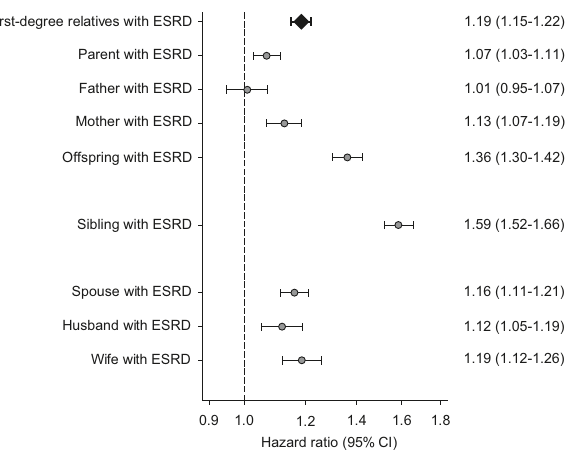
Figure 2. Risks of ESRD in patients with predialysis CKD having affected relatives with ESRD. All models were adjusted for age, sex, residential area, income level, and comorbidities such as hypertension, diabetes, ischemic heart disease, cerebrovascular disease, and dyslipidemia. CKD, chronic kidney disease; CI, confidence interval; ESRD, end-stage renal